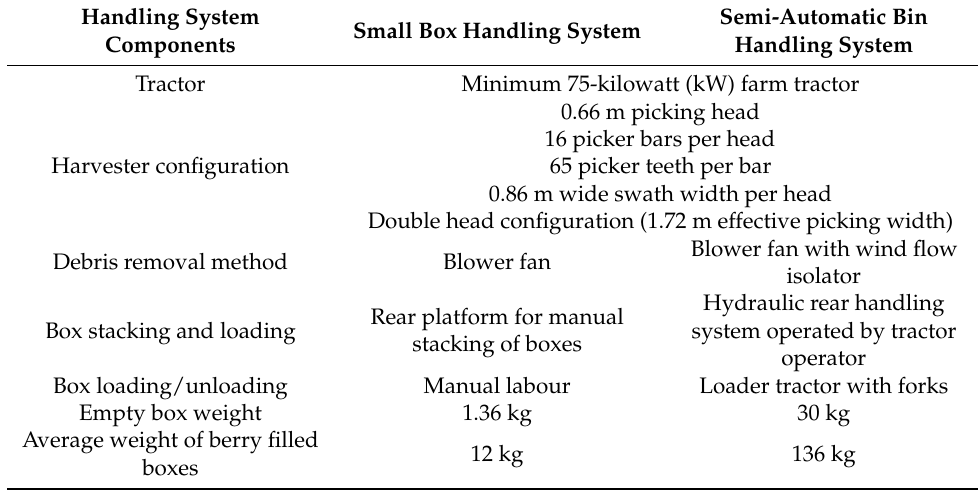
Table 1. Comparison of major characteristics of harvesters with alternative handling